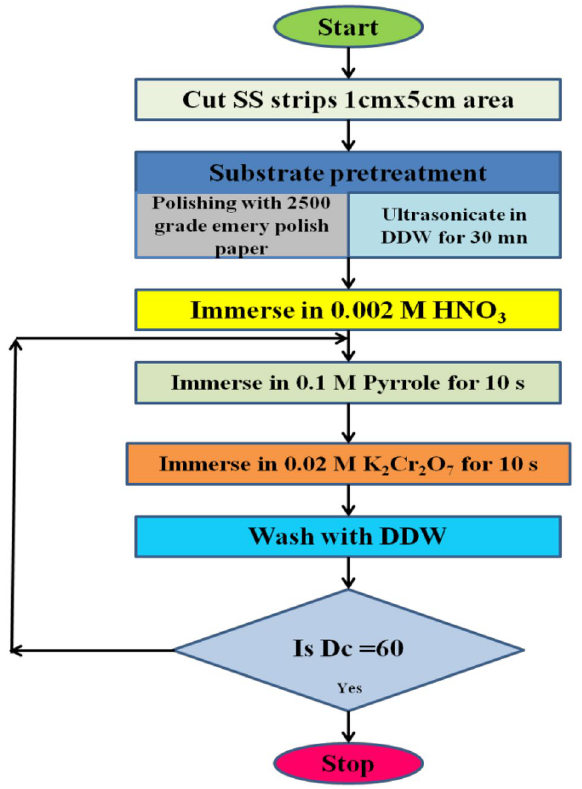
Fig. 1 Mechanism of SILAR synthesis of